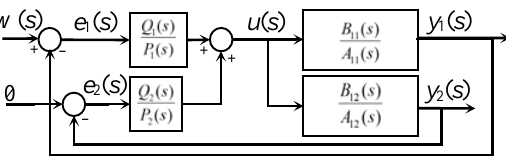
Figure 5 . Generalized representation of closed-loop control system for study case. Figure 5. Generalized representation of closed-loop control system for study